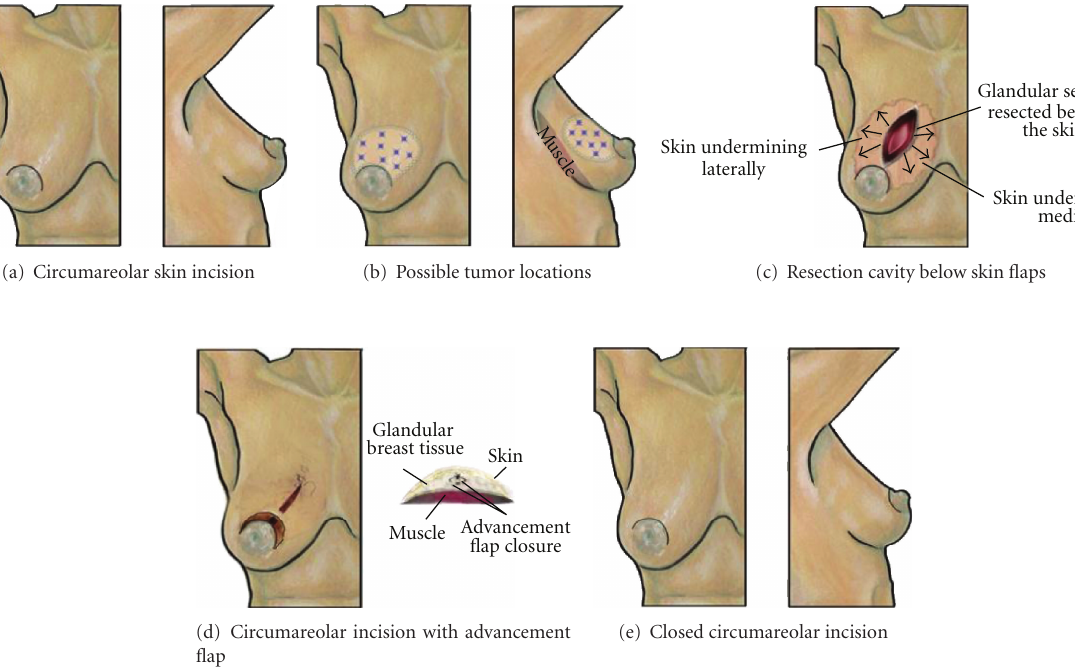
Figure 3: Circumareolar approach for segmental resection. (a) Shows location of circumareolar skin incision. (b) Shows multiple “stars” indicating possible tumor locations suitable for this approach. (c) Shows lumpectomy cavity after segmental resection of breast glandular tissue only with arrows denoting the extent of undermining of the overlying skin flap. (d) Shows results of glandular flaps advancements that allow the medial and lateral margins to be sutured together below the skin flap. Frontal and transverse views are shown. (e) Shows breast following closure of the circumareolar